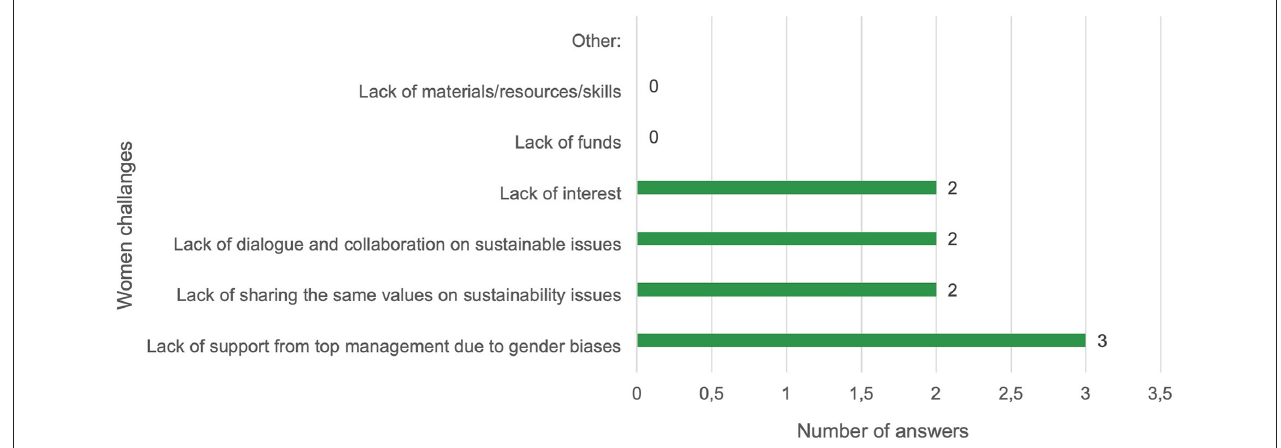
FIGURE 10 | Sustainability female leader